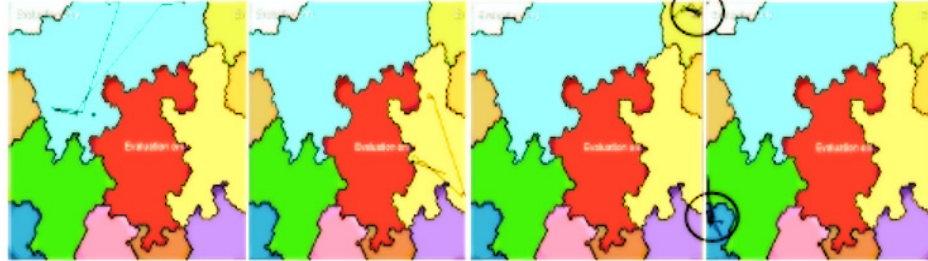
Figure 2. Kohonen topological map of borrowers’ scores.